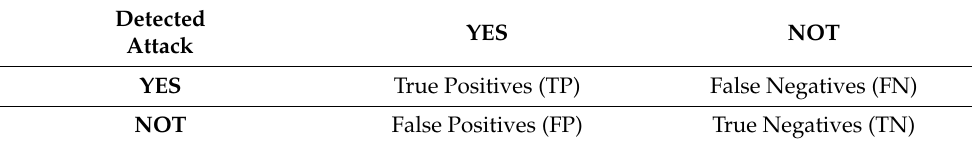
Table 1. Confusion